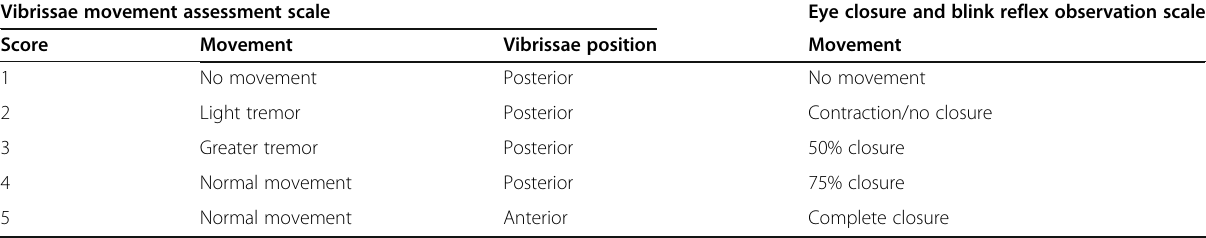
Table 1 Facial nerve functional behavioral test observation scale. Adapted from [45] Vibrissae movement assessment scale